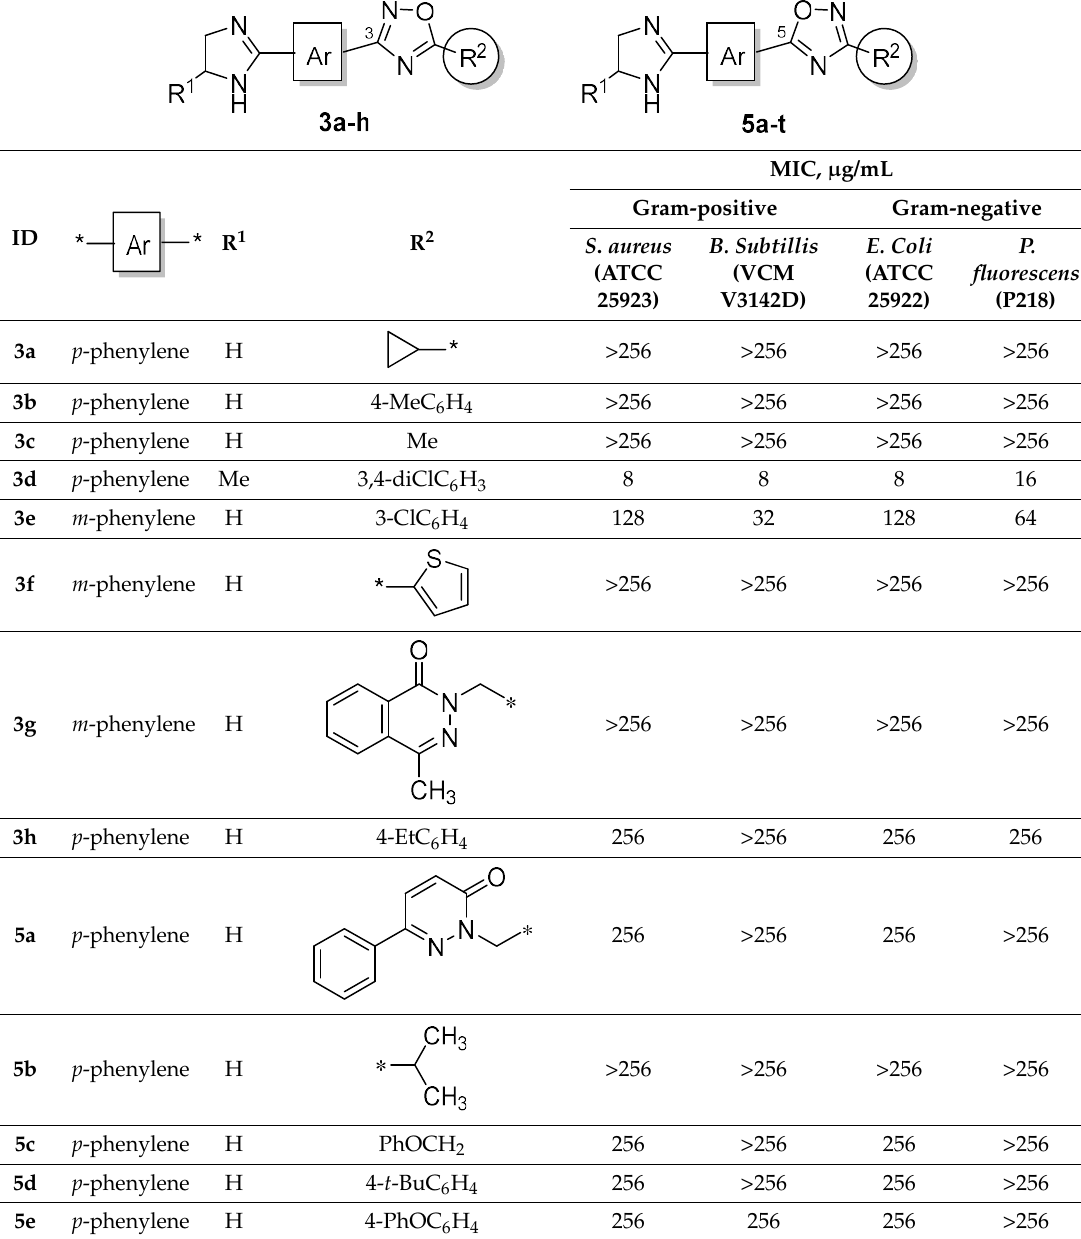
Table 1. Antibacterial activity compounds 3a-h and 5a-t .